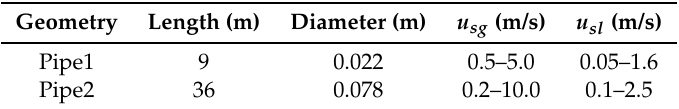
Table 1. Geometrical characteristics, mesh sizes and superficial velocity ranges of the pipes analyzed in the numerical